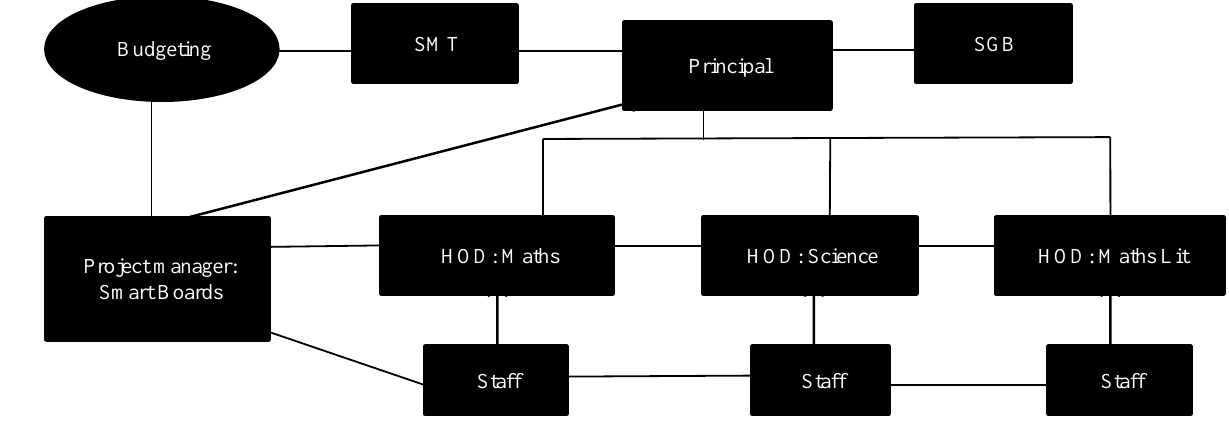
Figure 1 A Balanced Matrix